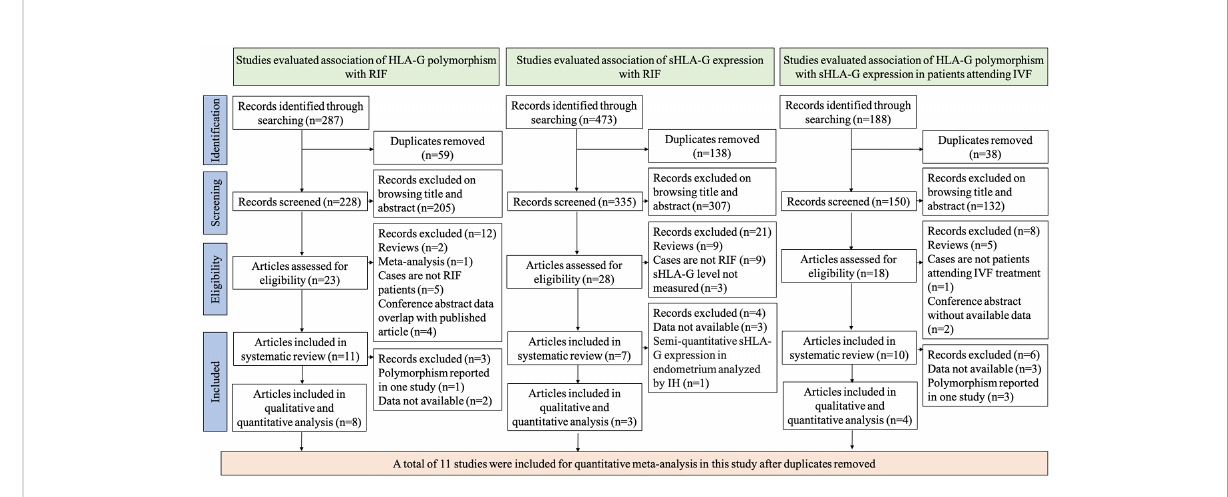
FIGURE 1 Flow chart of study